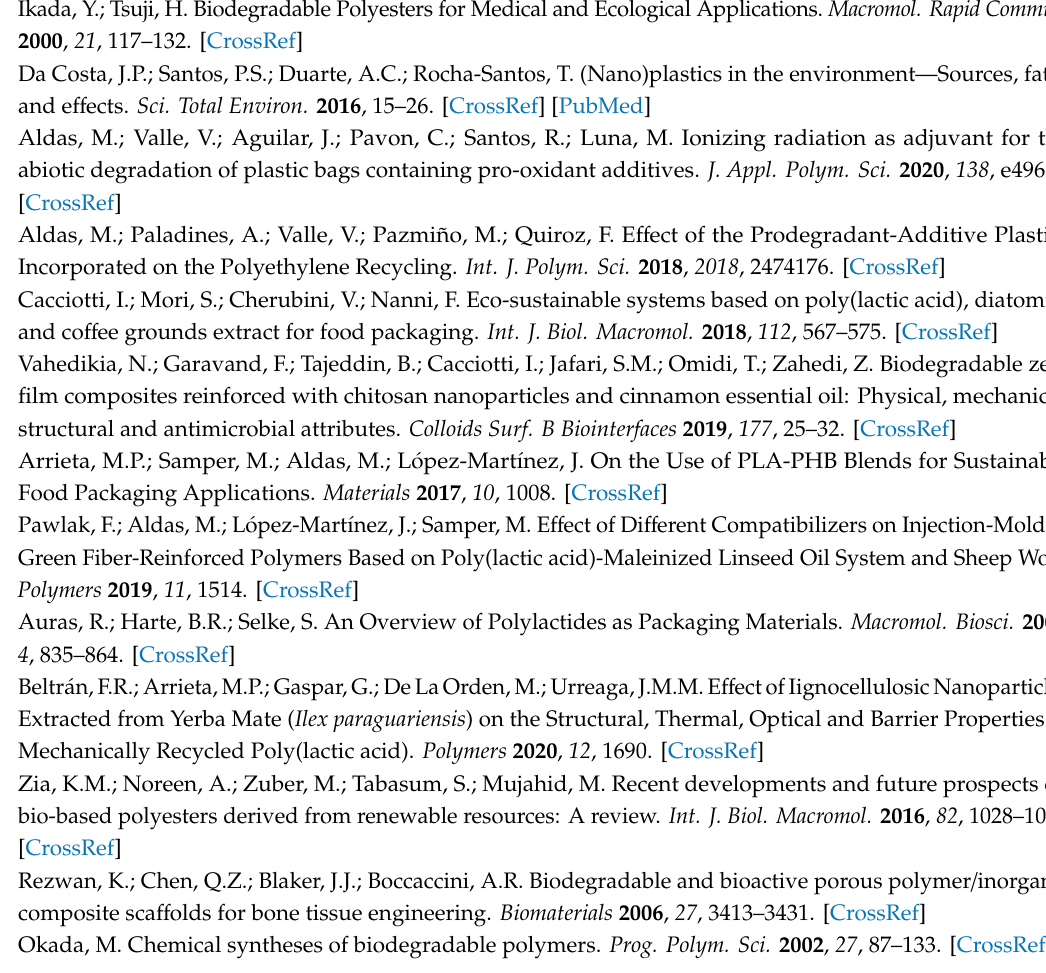
Figure S1: (a) TGA and (b) DTG curves of PBAT and PBAT-resin based formulations in 5, 10 and 15